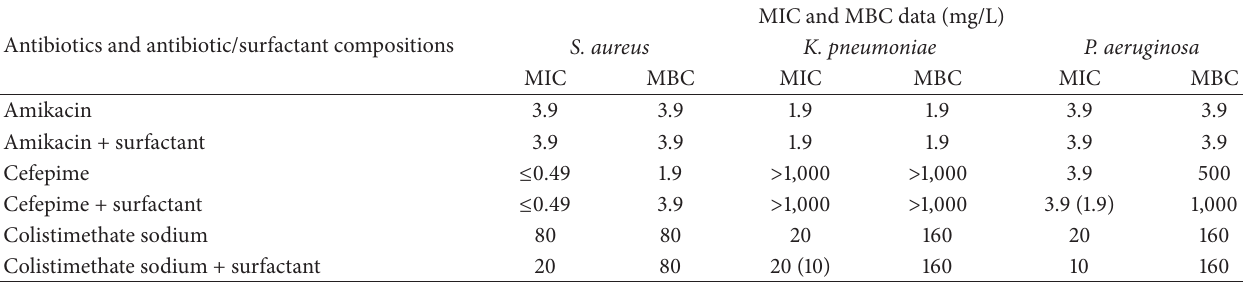
Table 3: Bacteriostatic and bactericidal characteristics of antibiotic solutions and experimental surfactant/antibacterial mixtures. Antibiotics and antibiotic/surfactant compositions